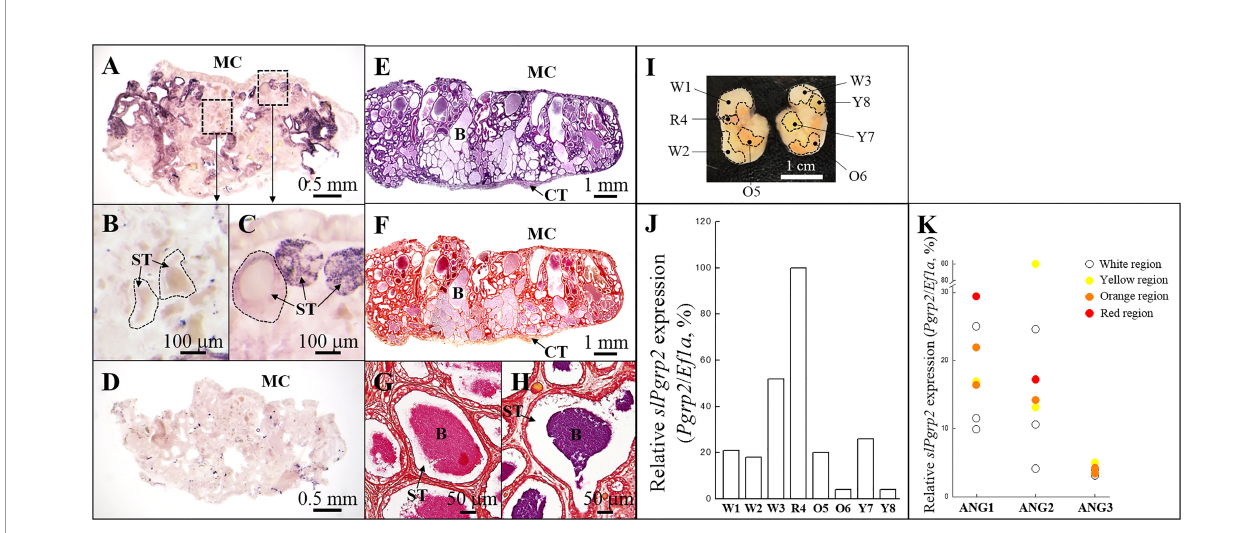
FIGURE 7 | Expression of slPgrp2 transcripts in different areas of ANG in the mature female squid. (A – C) slPgrp2 mRNA expression of ANG was detected by an antisense probe in mature female squid (stage 4). (D) Background staining was evaluated using a sense probe for slPgrp2 in serial sections. (E, F) Histological characteristics and Gram staining of ANG in mature female squid, respectively. (G, H) Gram staining in different secondary tubules of ANG. (I) Different regions in ANG were distinguished by color and isolated under a stereomicroscope. Each color region was analyzed separately. (J) Expression of slPgrp2 mRNA was analyzed by qPCR in different colors regions, as shown in (I) . (K) Four different colors of bacterial regions were detected and used for correlation with gene expression pattern: white, yellow, orange, and red. slPgrp2 mRNA expression showed high variability in areas with different regions, even between regions with the same color. Dash line in (B, C) denotes the border of secondary tubule. B, bacteria; MC, mantle cavity; ST, secondary tubule; W, white; R, red; Y, yellow; O, orange.